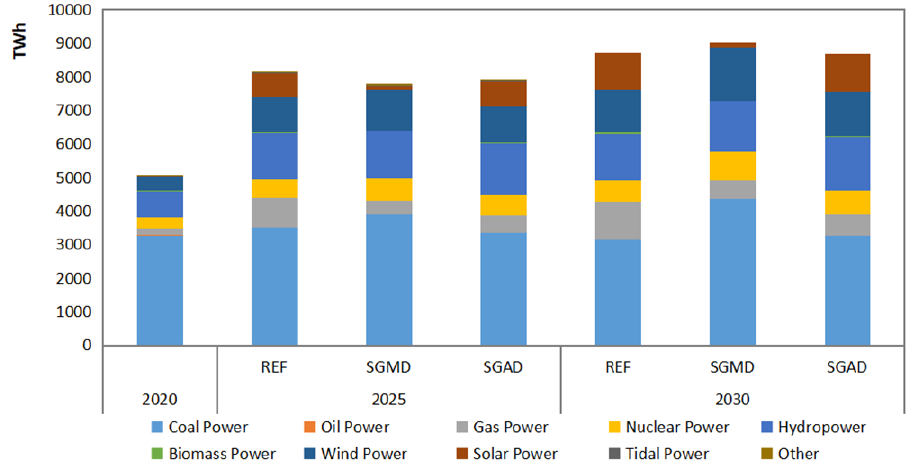
Figure 8. Power generation.